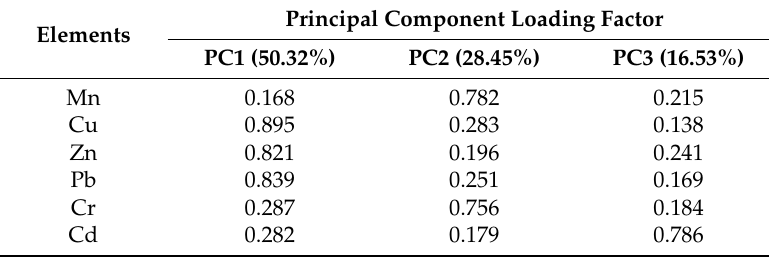
Table 6. Matrix of the principal component analysis loadings of soil